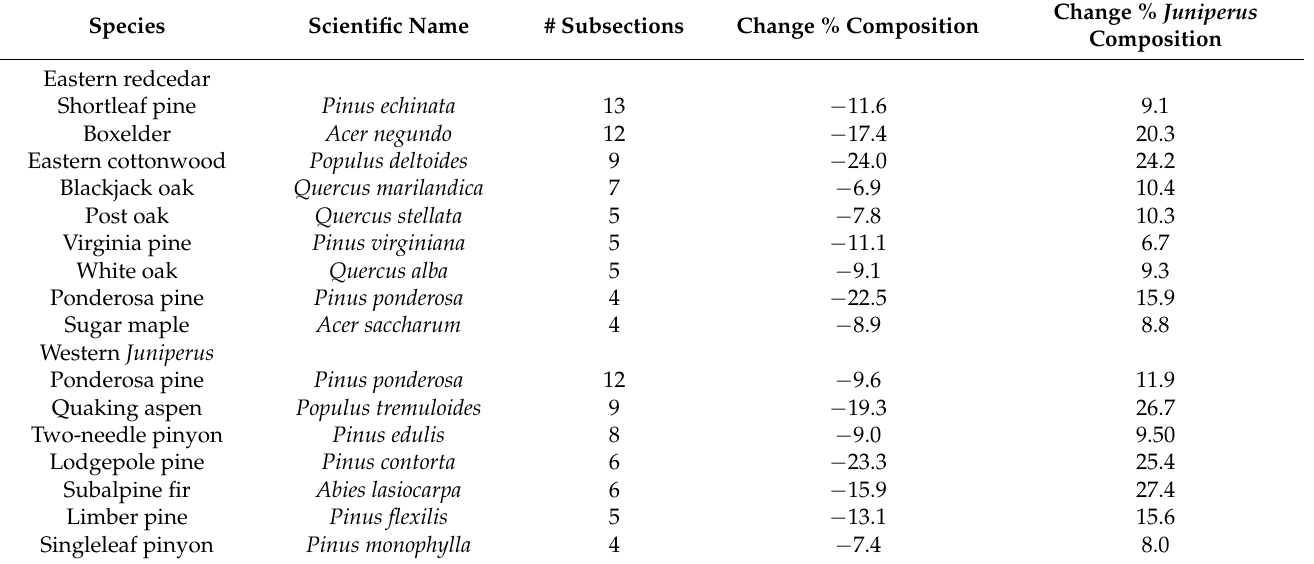
Table 2. Species that decreased by ≥ 5% composition where Juniperus species have increased by ≥ 5% composition.